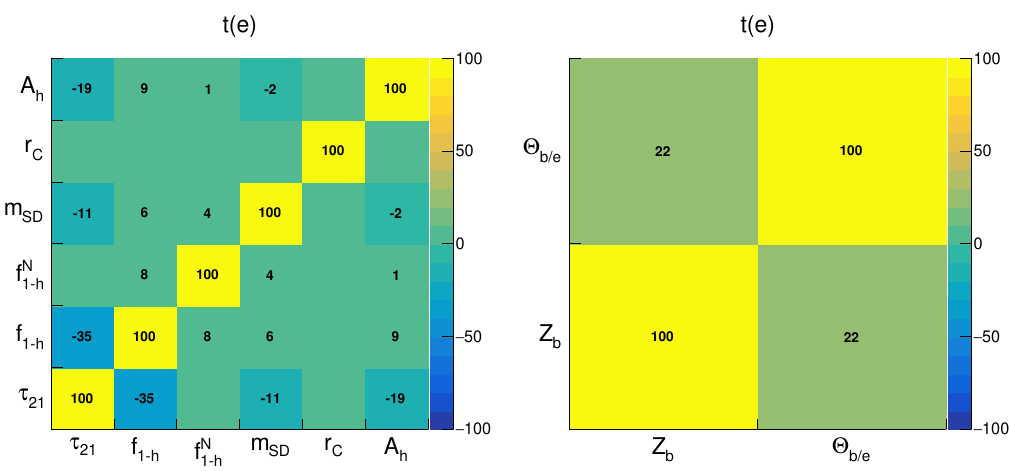
Figure 4 . Linear correlation coe(cid:14)cients (in %) between the variables in the sets V e (left), and V (cid:23) (right) respectively, for the sample of top quarks decaying to electrons.